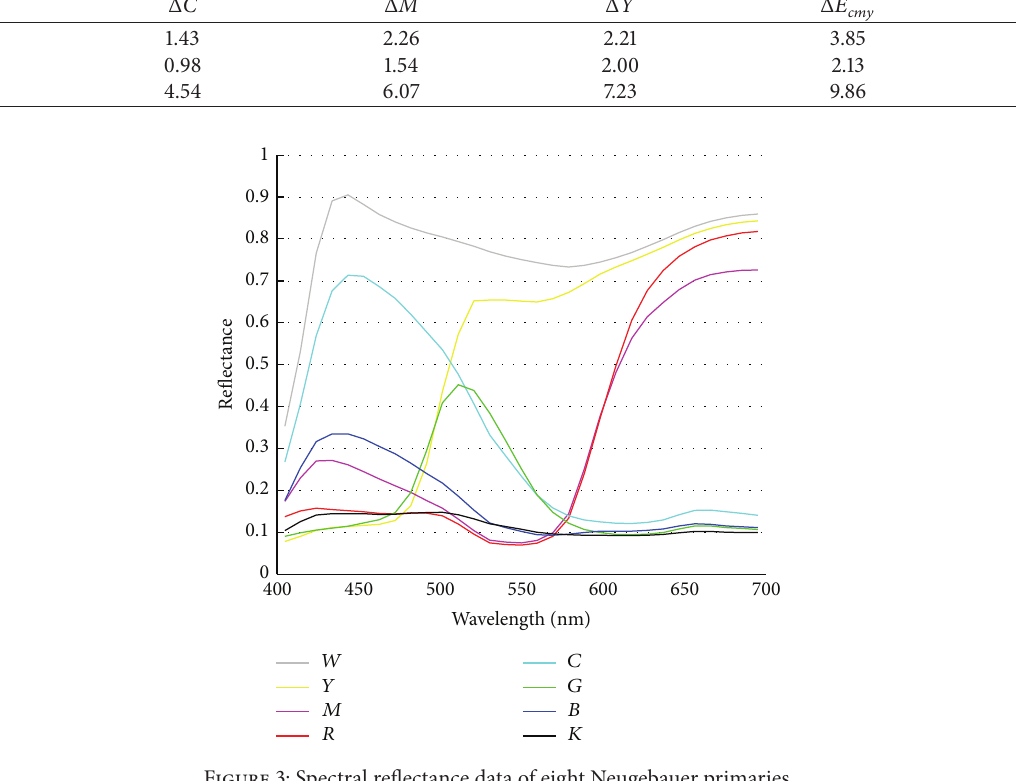
Figure 3: Spectral reflectance data of eight Neugebauer